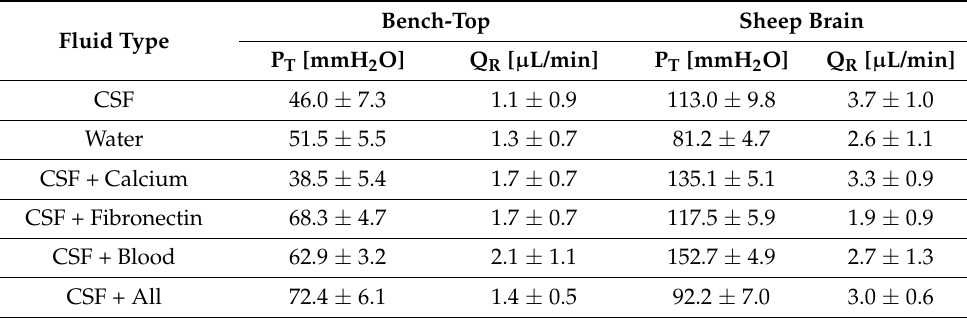
Table 1. Summary of specifications for hydrogel valves tested in worst-case